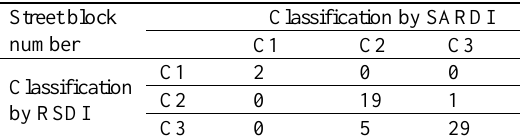
distribution map of the study area (Figure 7c).